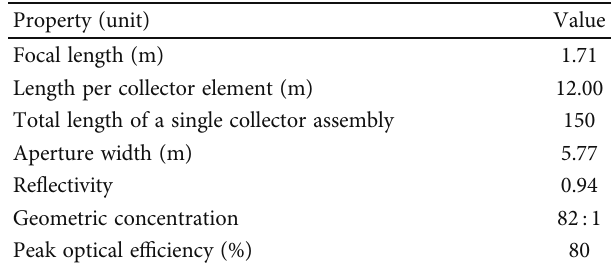
Table 2: Technical speci fi cations for the solar collector [42].